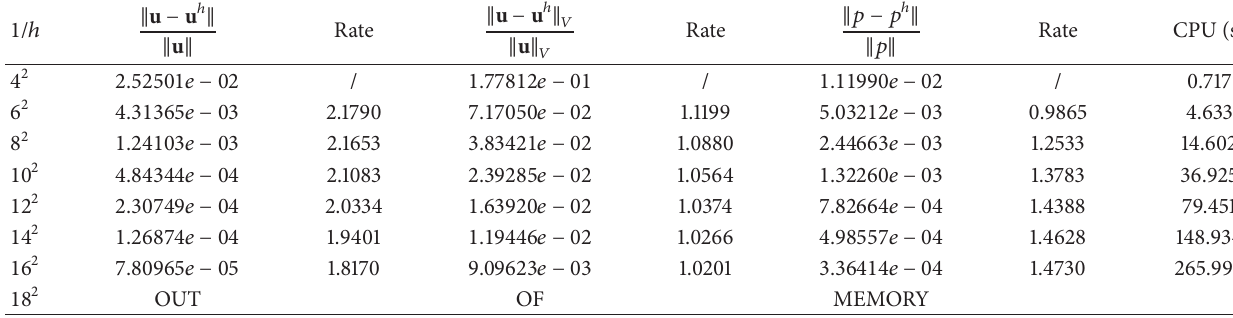
Table 1: Convergence of one-level method.